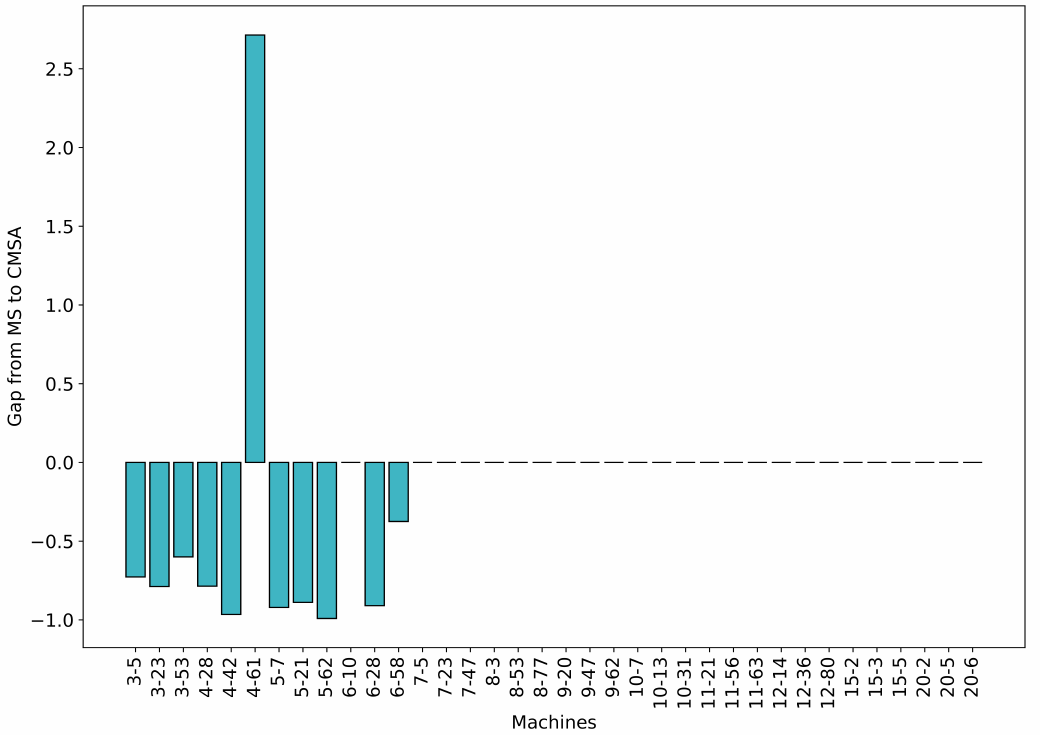
Figure 9. Comparing the computing time needed by MS and CMSA for solving the restricted MIPs when they are provided with the same set of solutions for one iteration. The boxes show the percentage difference of MS and CMSA, with a positive value indicating that MS took more computation